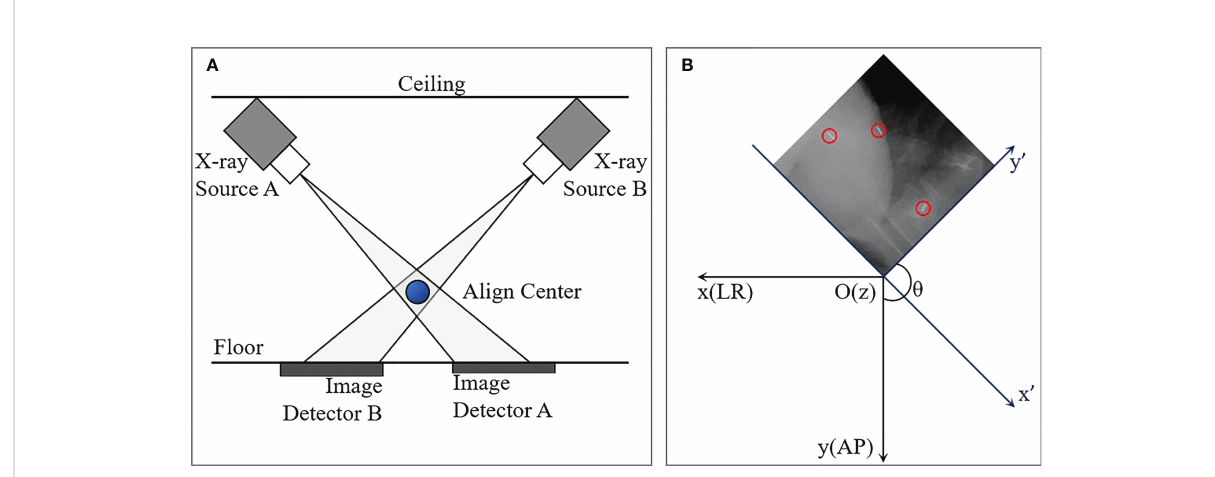
FIGURE 1 Diagram of the CyberKnife imaging system (A) and schematic of coordinate transformation between image coordinate system ( x " , y " ) and patient coordinate system ( x , y ). The blue ball in (A) is the align center. The blue and black axes in (B) represent image and patient coordinate systems, respectively. The red circles indicated fi ducials detected on kV